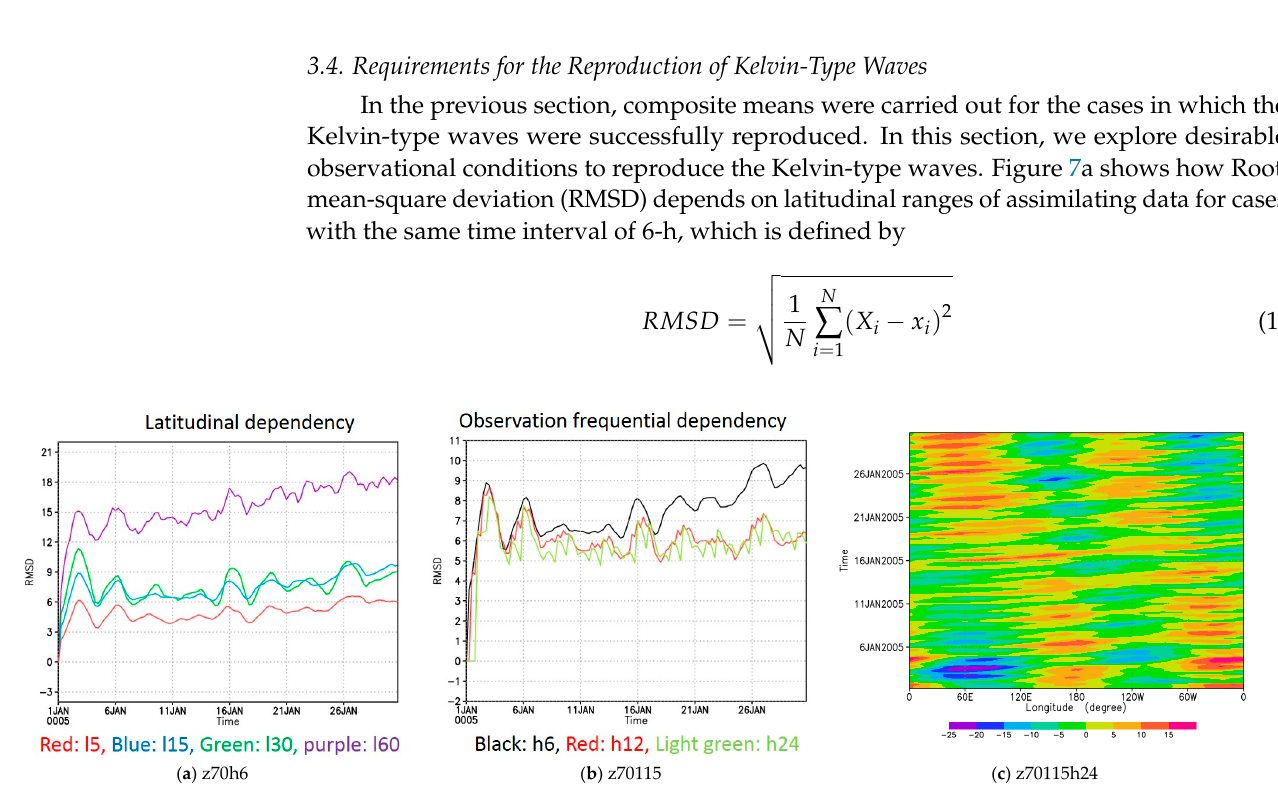
Figure 7. Root-mean-square deviation (RMSD) of zonal wind (analysis) from that of frf at 70 km calculated by Equation (1) from 1 January 2005. ( a ) Latitudinal dependency in case of assimilating data at the same time interval of 6 h. ( b ) Observation frequential dependency in case of assimilating data at the same latitudinal range of 15 ◦ S–15 ◦ N. ( c ) Longitude-time cross sections of zonal wind deviation from its time average at 70 km altitude at the equator from 1 January 2005 for z70l15h24